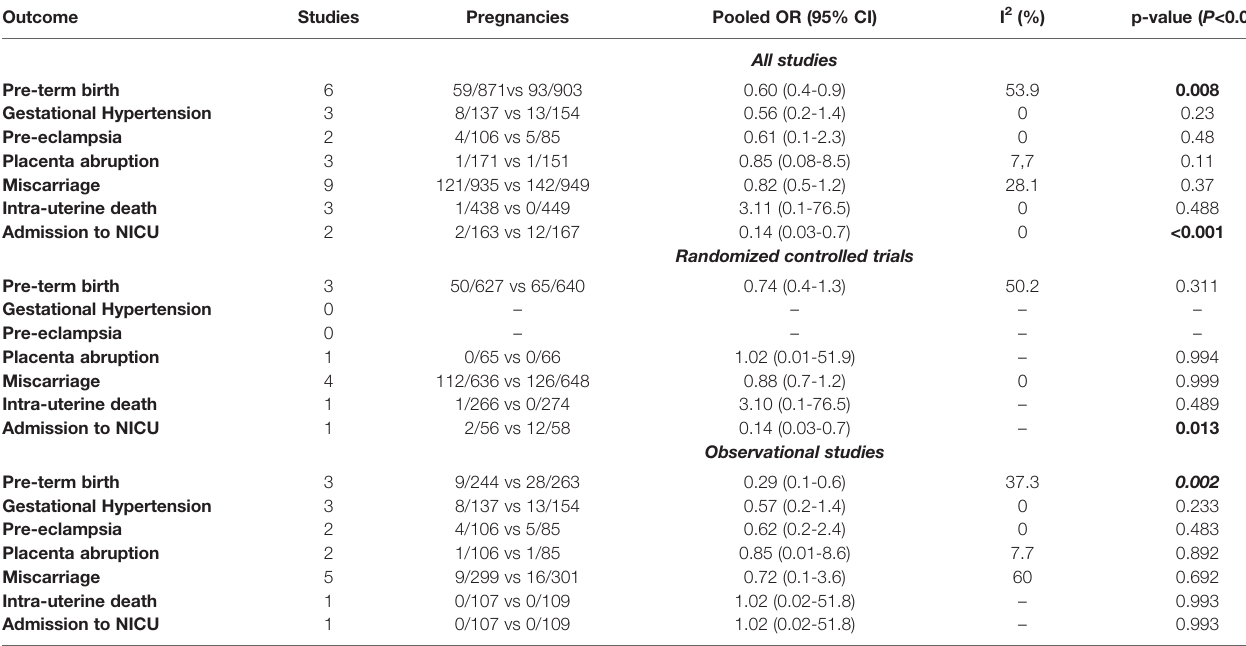
NICU, neonatal intensive care unit. Bold values are statistically signi fi cant.